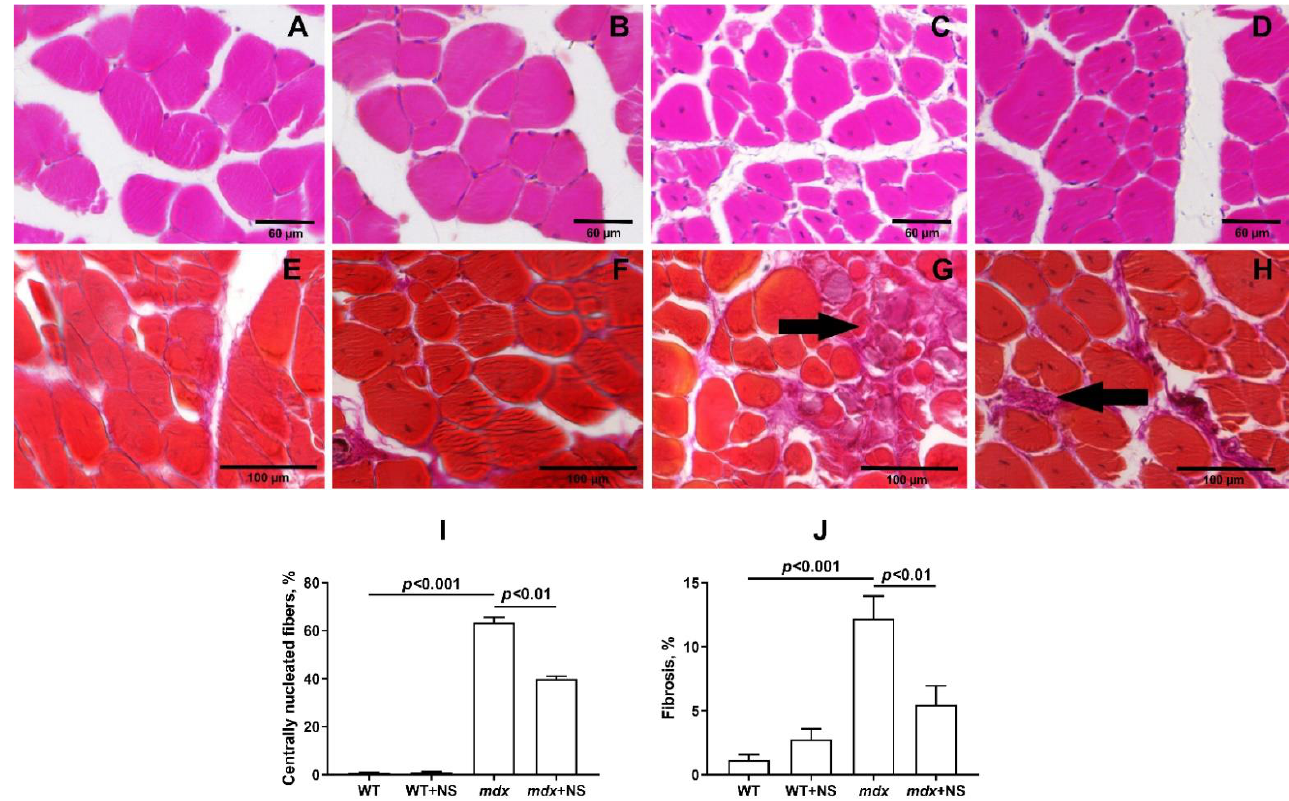
Figure 8. Representative histology images of skeletal muscle tissue (quadriceps) showing myofibers containing centrally located nuclei ( A – D ) and fibrotic area (( E – H ), black arrows) from the WT ( A , E ), WT + NS1619 ( B , F ), mdx ( C , G ) and mdx + NS1619 ( D , H ) groups of mice. The bars are equal to 60 ( A – D ) and 100 μm ( E – H ). Diagram ( I , J ) show the percentage of myofibers containing centrally located nuclei and the amount of interstitial fibrosis in the skeletal muscles of the experimental animals. The data are presented as m ± SEM. The level of fibrosis was evaluated as the percentage ratio of the hematoxylin van Gieson (HvG) staining areas (pink) that represented collagen and other connective tissue elements in the common area of the tissue, wherein at least 10 sections were analyzed for each sample. Quantitative data of the centrally nucleated fibers from H&E staining are from an average of 8 – 10 unique visual fields from each animal and expressed as a percentage of the total number of myofibers counted.